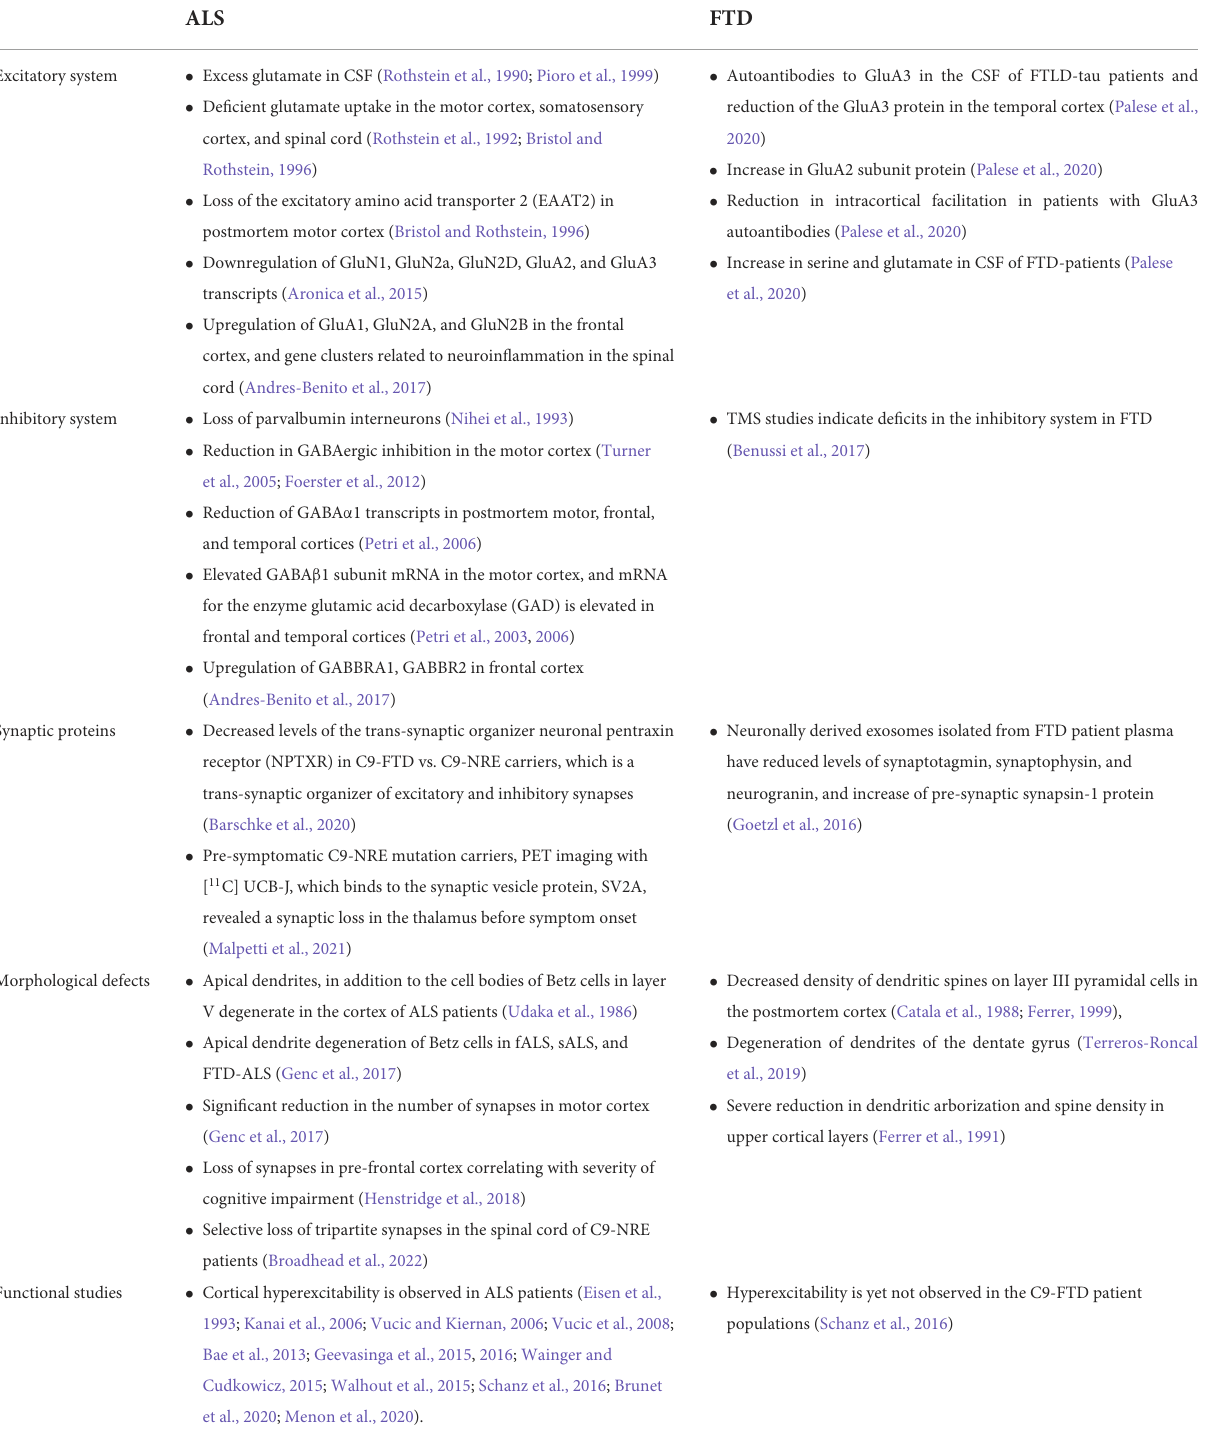
TABLE 1 Evidence of synaptic dysfunctions observed in ALS and FTD patients and postmortem tissue. ALS